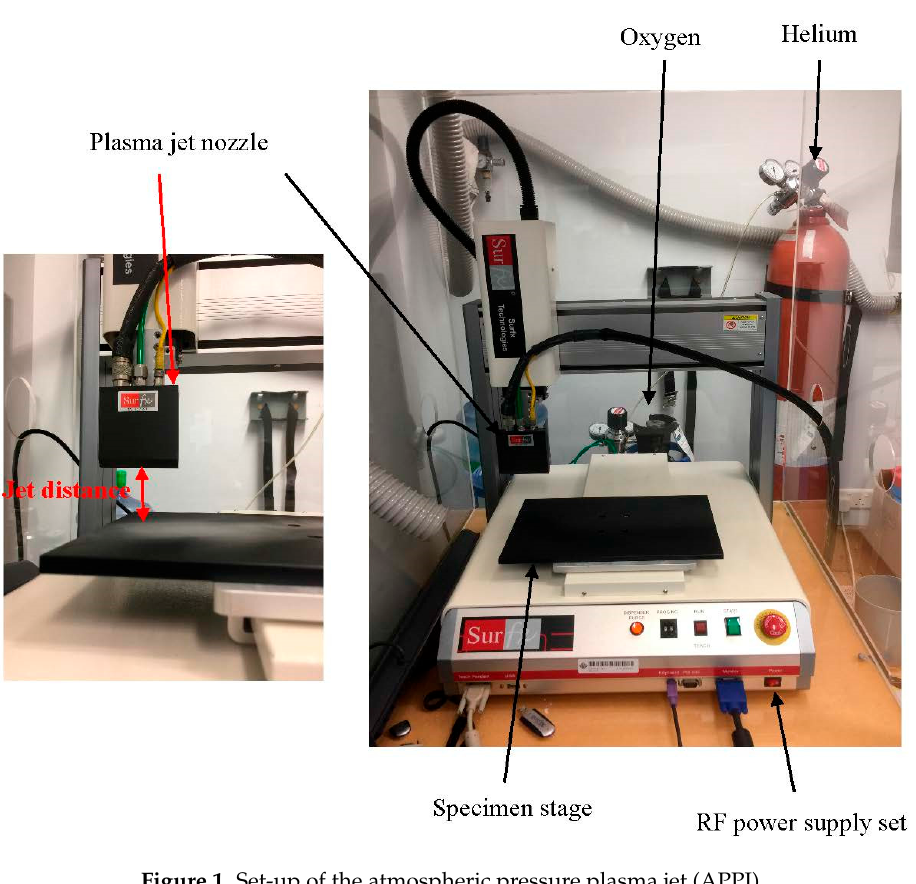
Figure 1. Set-up of the atmospheric pressure plasma jet (APPJ).